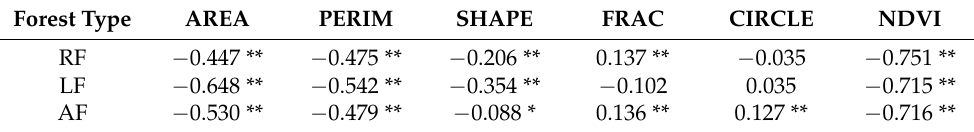
Table 3. Correlations of forest patch characteristic parameters and PM 2.5 concentration.